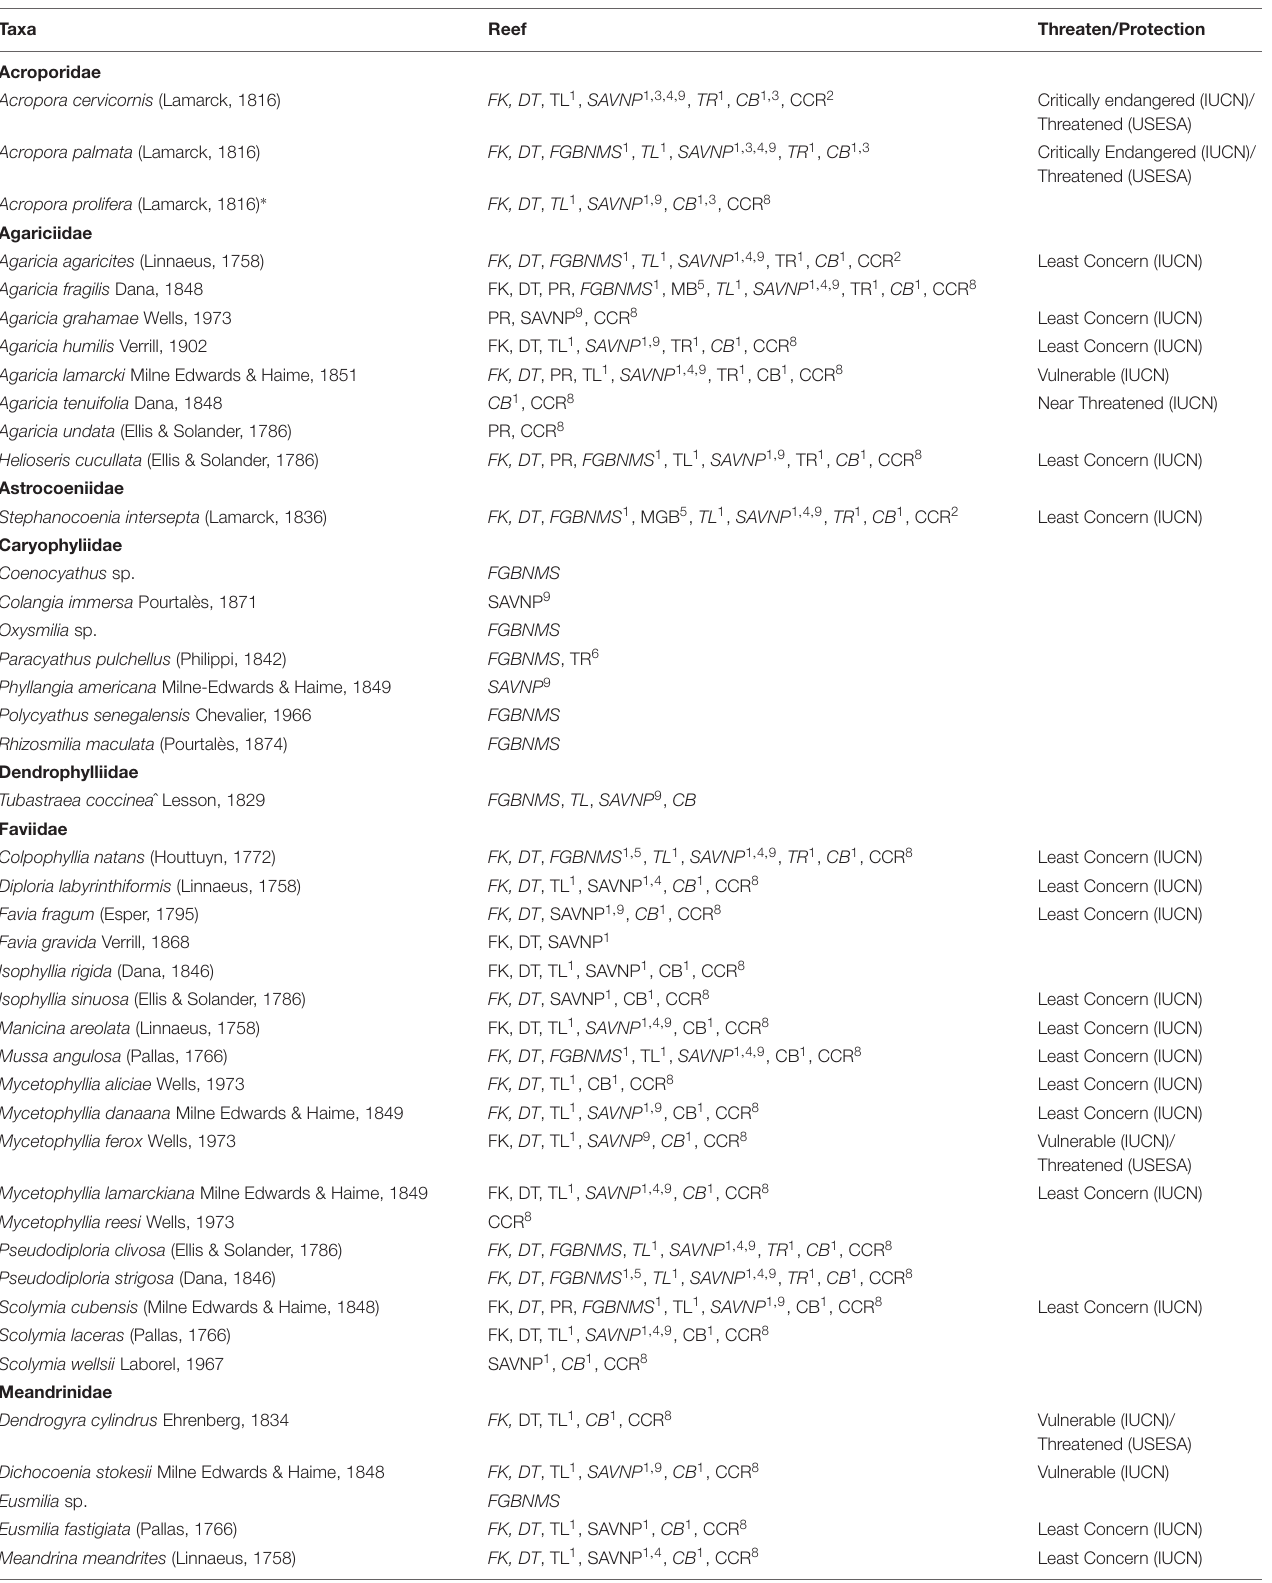
TABLE 3 | Scleractinian coral species by reef system (Reef) in the Gulf of Mexico ordered alphabetically by Family name. Taxa